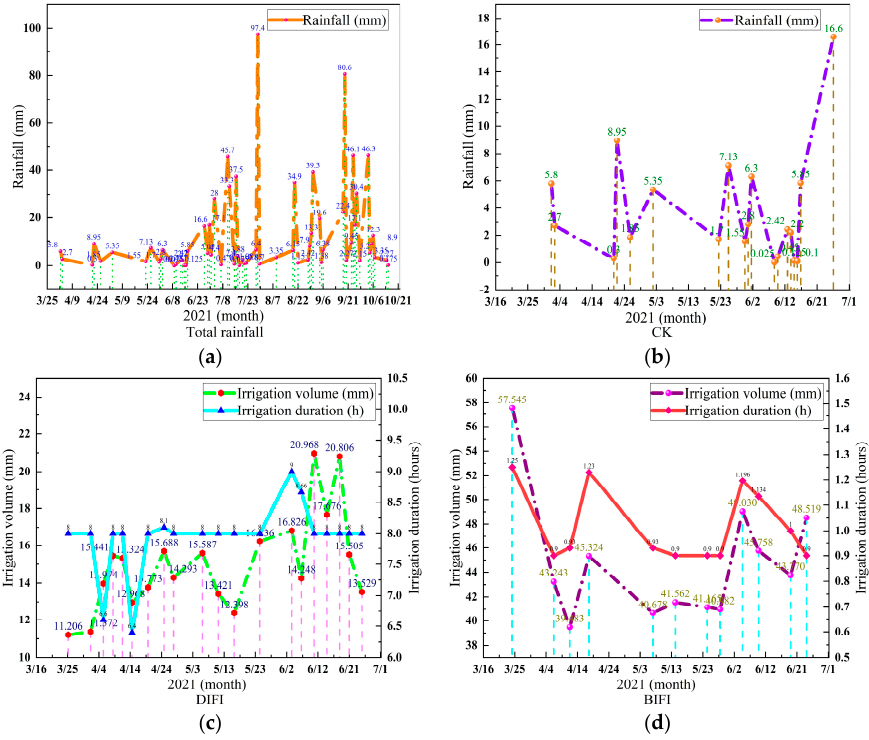
Figure 6. Rainfall data: ( a ) annual rainfall, ( b ) CK rainfall, ( c ) DIFI irrigation volume and duration, ( d ) BIFI irrigation volume and duration.